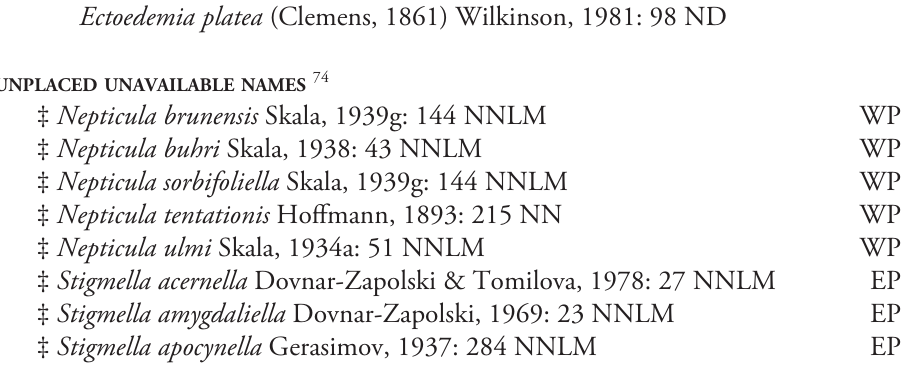
Stigmellites sharovi Kozlov, 1988: 33 EP† Stigmellites tyshchenkoi Kozlov, 1988: 33 EP† Stigmellites zelkovae Straus, 1977: 61